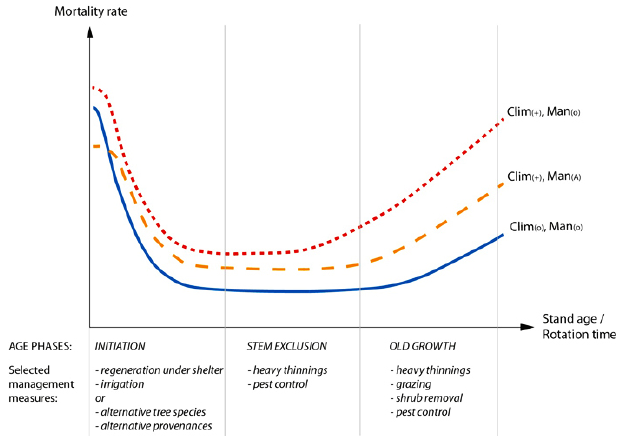
Fig. 4 . Illustrative example of feedbacks of management and climate change on nonlinear tree mortality in the course of forest stand development. Clim(o) = climate today; Clim (+) = climate change; (Man(o) = today’s management; Man (A) = adapted management. The diagram refers to Scots pine ( Pinus sylvestris ) growing in a dry environment and is derived from a simulation study including thinning and grazing/shrub removal (Elkin and Bugmann